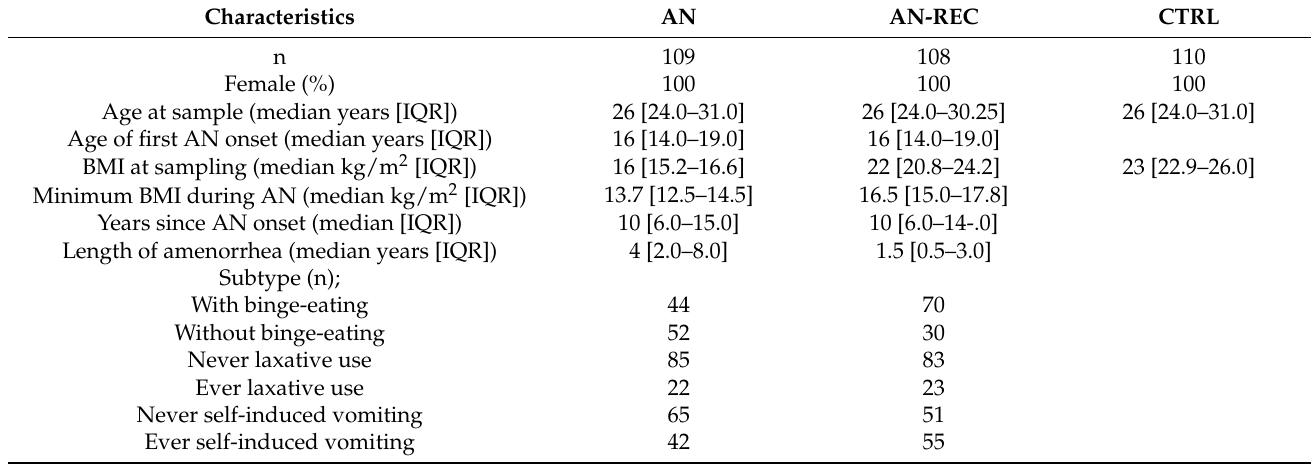
Table 1. Sex, age, BMI, years since AN onset, length of amenorrhea, binge behavior, laxative usage, and self-induced vomiting of the study participants by